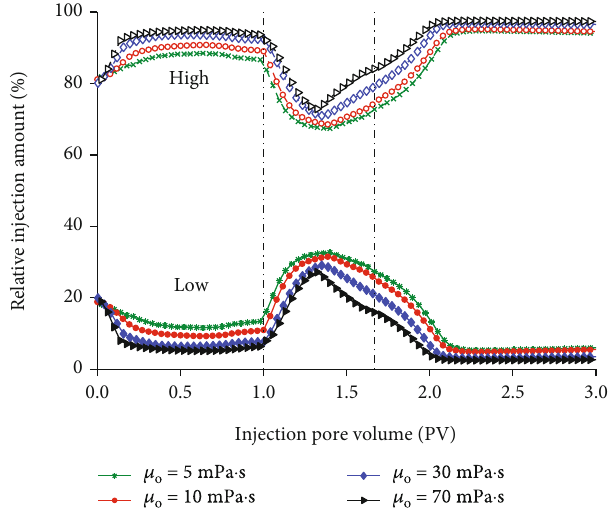
Figure 6: Injection conformance behavior for reservoirs with di ff erent oil